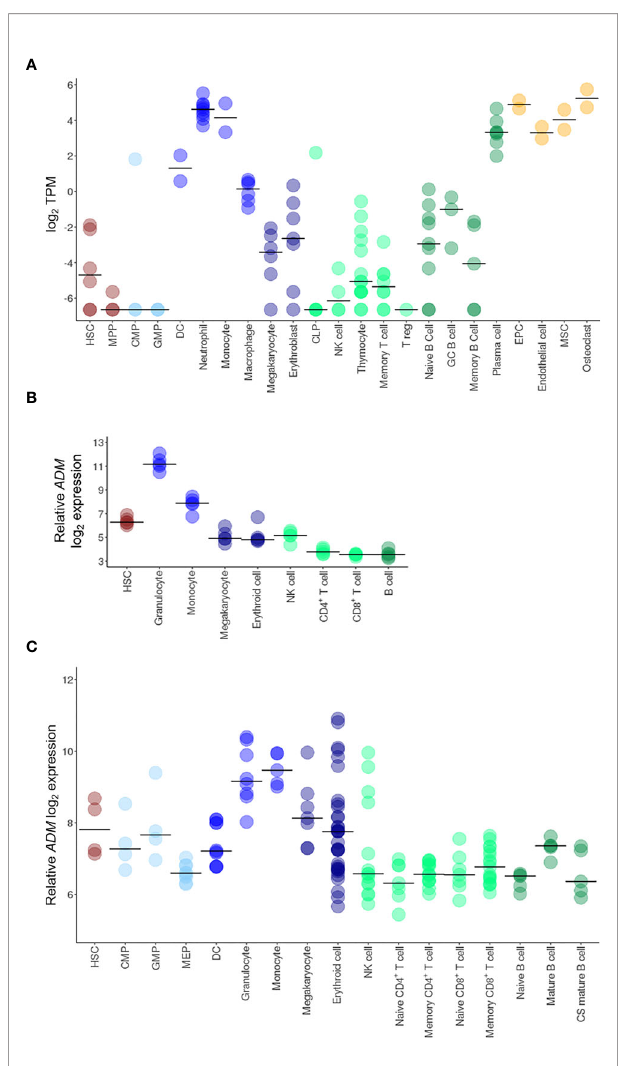
FIGURE 1 | ADM expression in HSC and in the hematopoietic system. Transcriptional analysis of ADM expression in hematopoietic cells from the BLUEPRINT (A) , the GSE98791 (B) and the GSE24759 (C) datasets. Scatter plots were generated with the R package ggplot2 (48) (version 3.3.1). Each dot indicates one sample and the bar represents the median value (HSC, hematopoietic stem cells; MPP, hematopoietic multipotent progenitor cells; CMP, common myeloid progenitors; GMP, granulocyte – monocyte progenitors; DC, conventional dendritic cells, CLP, common lymphoid progenitors; NK, natural killer; T reg, regulatory T cells; GC, germinal center; EPC, endothelial progenitor cells; MSC, mesenchymal stem cells; MEP, megakaryocyte-erythroid progenitors; CS, class-switched; TPM, Transcripts Per